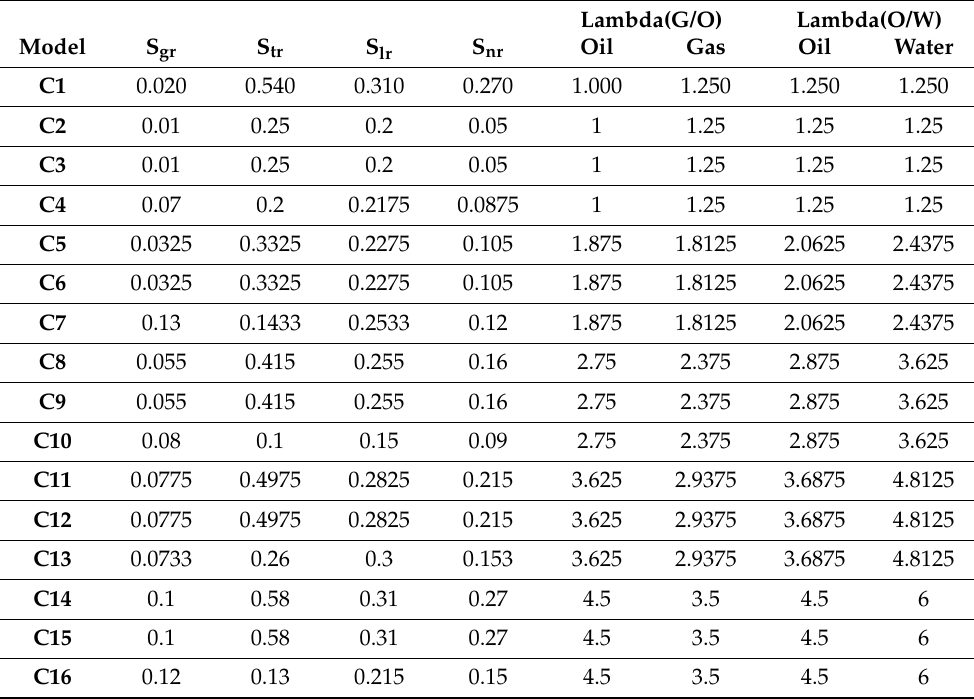
Table 1. Phase residual saturation and curve parameter lambda used in Equations (1)–(4) to create the relative permeability curves used in this study.